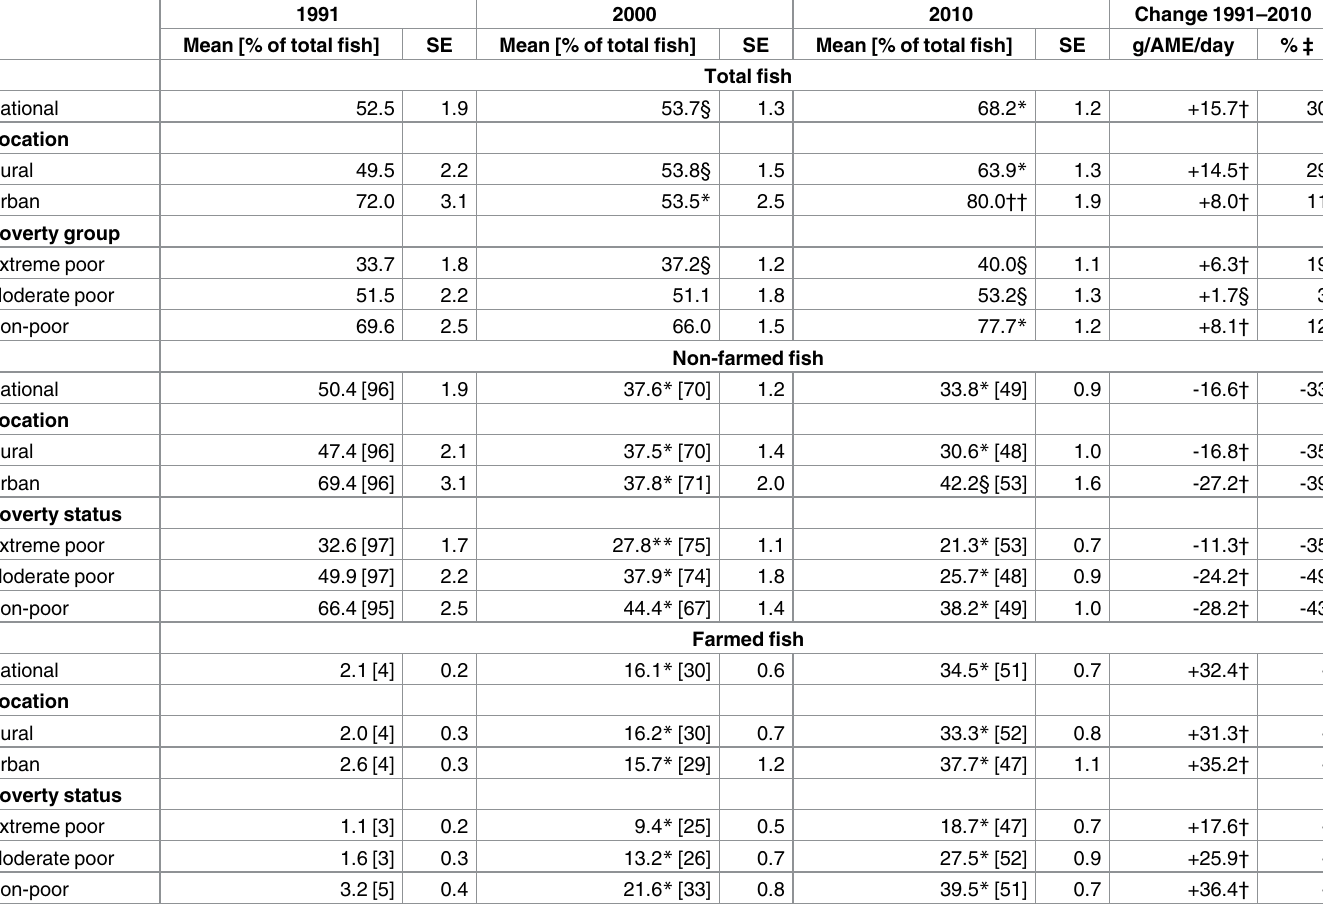
Table 2. Mean total, non-farmed and farmed fish consumption (g/AME/day, % of total fish) over